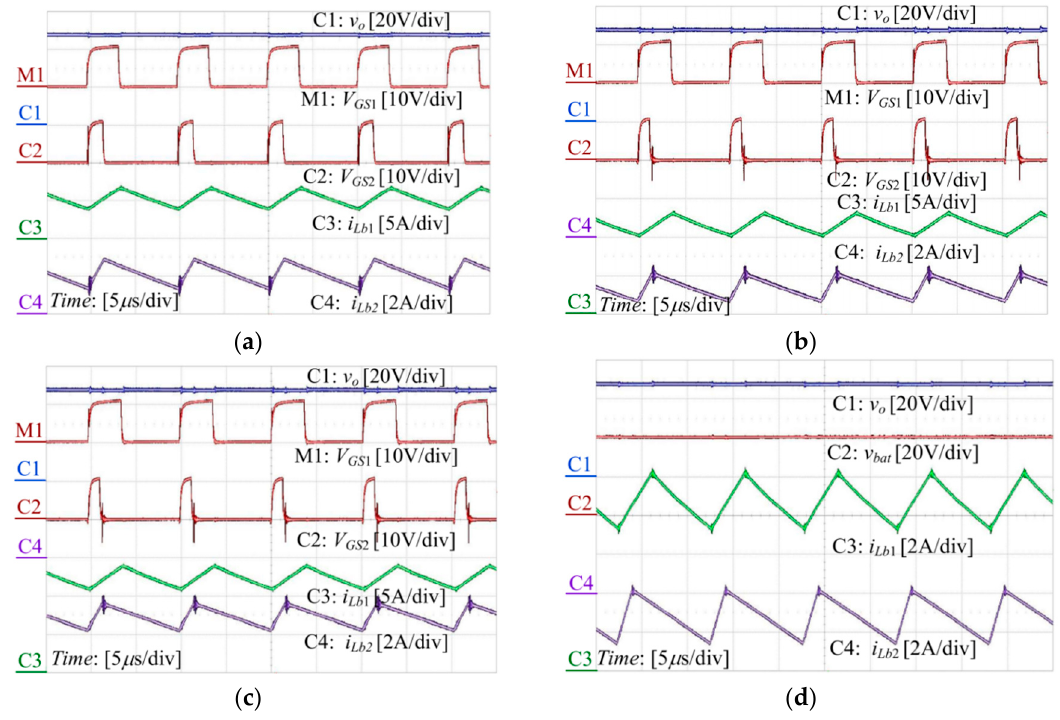
Figure 9. Steady experiment waveforms in three operating modes: ( a ) M 1 with I pvref = 0.53 A, and V ocbat = 39 V; ( b ) M 1 with I pvref = 1.1 A, V ocbat = 39 V; ( c ) M 2 with I pvref = 2.5 A, and V ocbat = 39 V; ( d ) M 3 with I pvref = 2.5 A, and V ocbat ≈ 40 V.